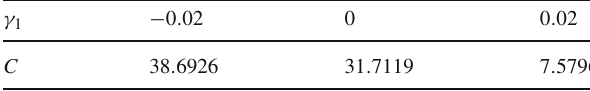
Table 3 The constant C in Eq. (15) with different γ . Here γ 1 = 0 Table 4 The constant C in Eq. (15) with different γ 1 . Here γ =